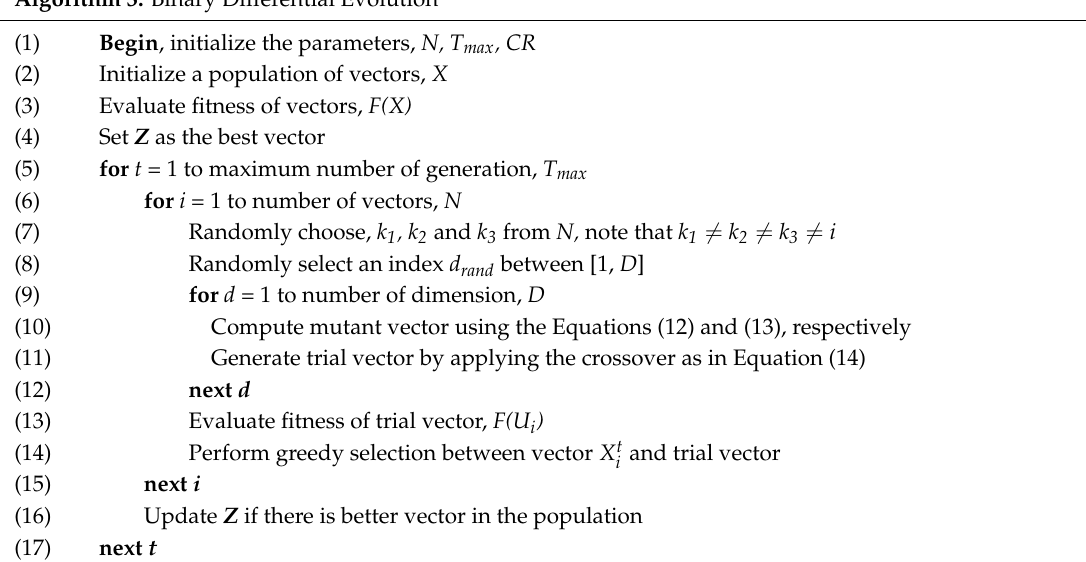
Algorithm 3. Binary Differential